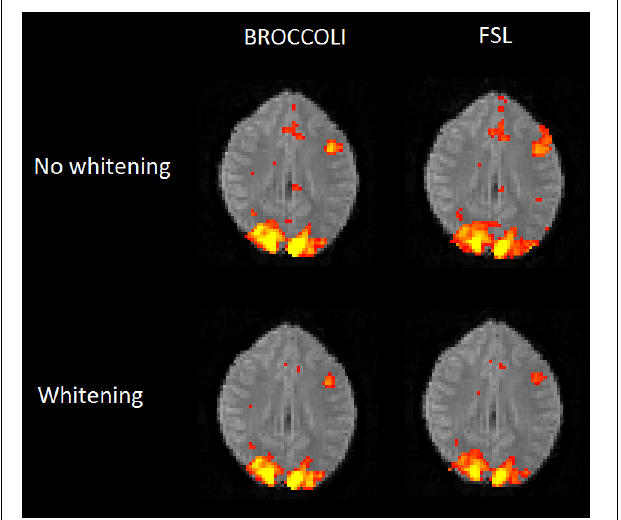
FIGURE 10 | Brain activity maps (representing t -values) from first level analysis of one OpenfMRI dataset, for BROCCOLI and FSL. Subjects were presented with pairs of either words or pseudowords in a block based design, and made rhyming judgments for each pair. The first level analysis here includes motion correction, segmentation of the fMRI data, smoothing, and statistical analysis. Both BROCCOLI and FSL used motion regressors in the statistical analysis. As BROCCOLI and FSL use different models of the GLM residuals, we here present activity maps with and without whitening. The activity maps have been arbitrarly thresholded at a t -value of